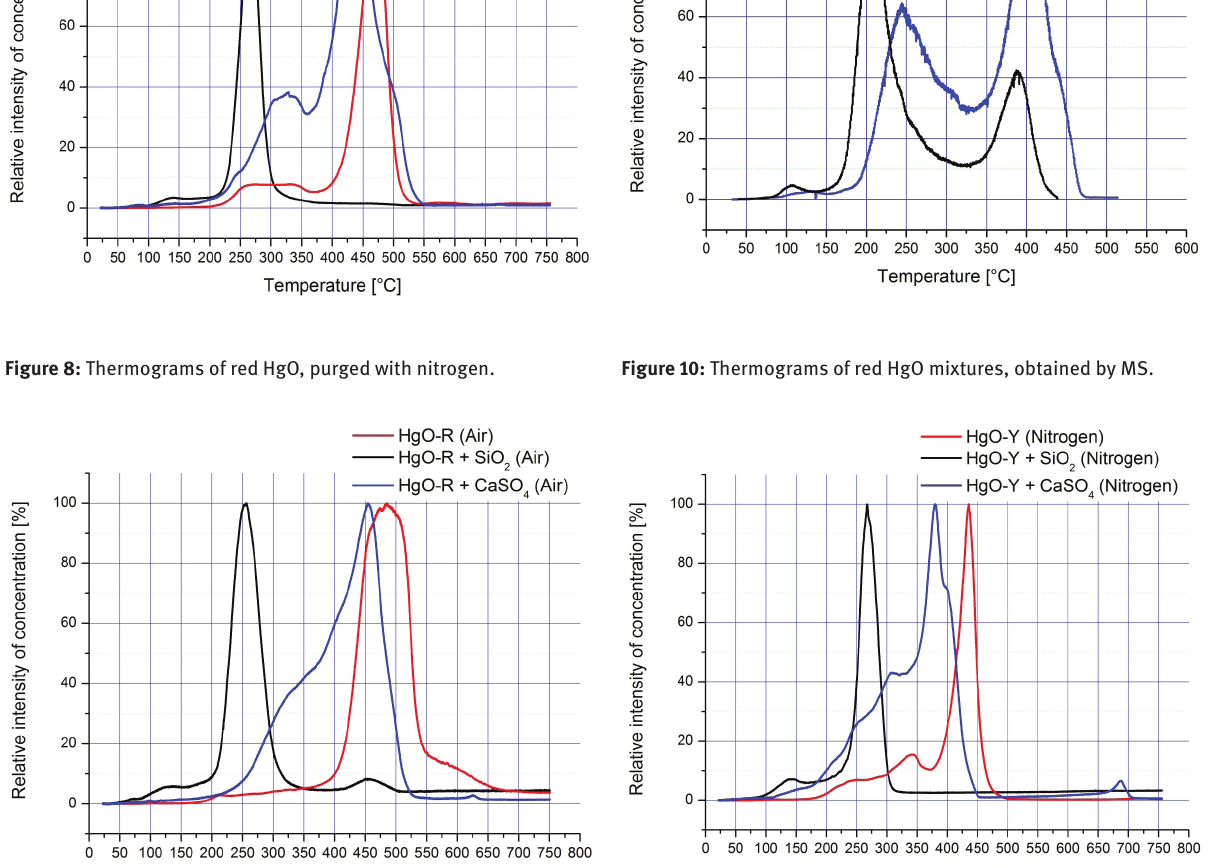
Figure 9: Thermograms of red HgO, purged with air.